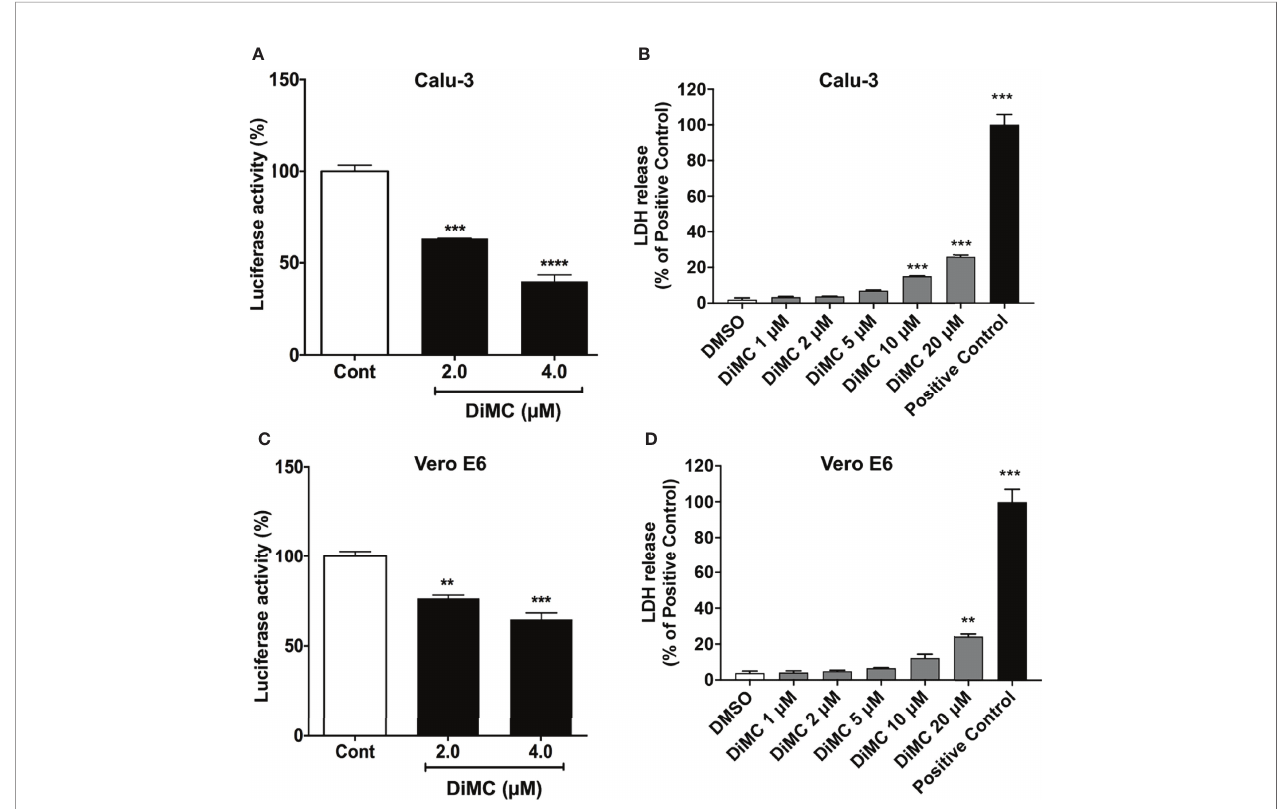
FIGURE 1 | DiMC blocked SARS-CoV-2 spike protein-mediated cellular entry of pseudo-SARS-CoV-2: DiMC treatment (2.0 and 4.0 µM for 18 h) signi fi cantly attenuated SARS-CoV-2 spike protein-mediated pseudo-SARS-CoV-2 cellular entry as indicated by decreases in luciferase activity in both Calu-3 (A) and Vero E6 (C) cells (n = 3, **p <0.01, ***p <0.001, ****p <0.0001). As indicated by LDH cytotoxicity assay, DiMC at the concentration of 5 m M or lower was not toxic to Calu-3 cells (B) or Vero E6 cells (D) (n = 3, ***p